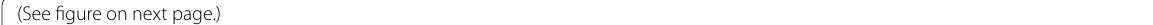
(See figure on next Fig. 14 Observed and calculated strain (right panel) and tilt (left panel) data during 29 December 2015 to 7 January 2016. Map region corresponds to Area A in Fig. 1. a Strain and tilt data for the first period (29 December 2015 to 1 January 2016) from observations (blue) and calculated from the estimated slip distribution shown in Fig. 12a (white). b Strain and tilt data for the second period (1 January to 1200 on 5 January) from observations and calculated from the estimated slip distribution shown in Fig. 12b. c Strain and tilt data for the third period (1200 on 5 January to 7 January) from observations and calculated from the estimated slip distribution shown in Fig. 12c